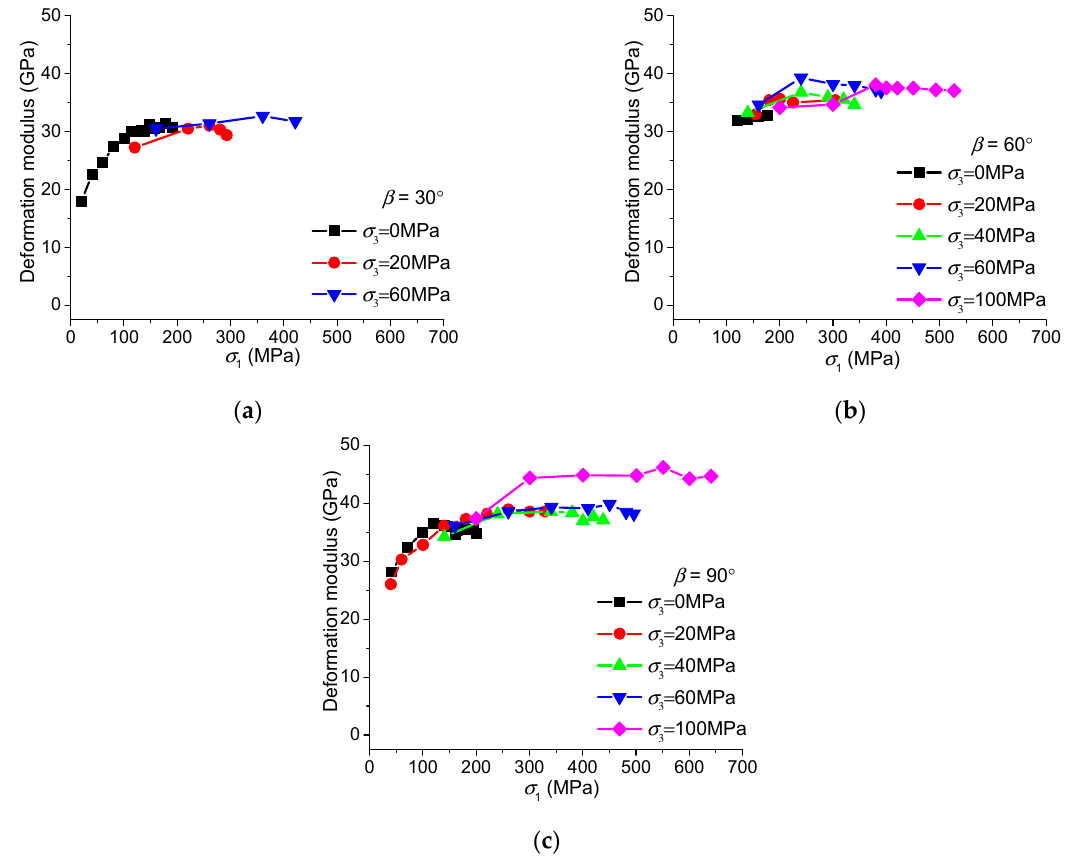
Figure A1. Deformation modulus with the increase of axial stress for the shale samples with different oriented weak planes (( a ) β = 30 ° , ( b ) β = 60 ° , and ( c ) β = 90 °) under various confining pressures.